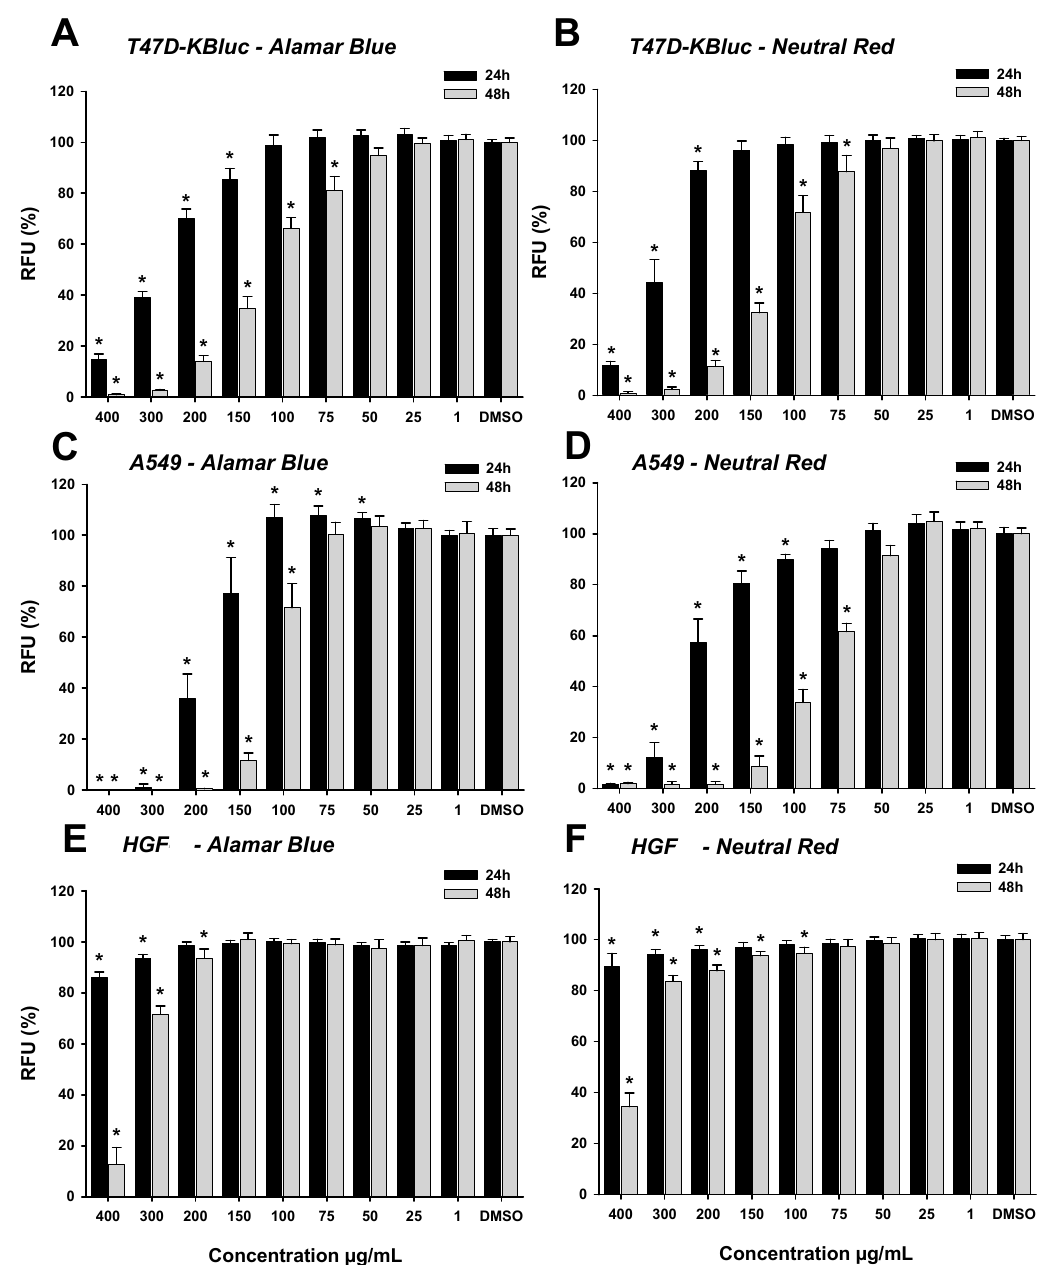
Figure 5. Cytotoxic e ff ect of the HI extract observed using Alamar Blue assay on T47D-KBluc ( A ), A549 ( C ), and HGF ( E ) and using Neutral Red assay on T47D-KBluc ( B ), A549 ( D ), and HGF ( F ). The results are expressed as relative means ± standard deviations (six technical replicates for each of the three biological replicates) where the negative control (DMSO 0.2%) is 100%. (*) indicates significant di ff erences compared to negative control (ANOVA + Dunnett’s; p <